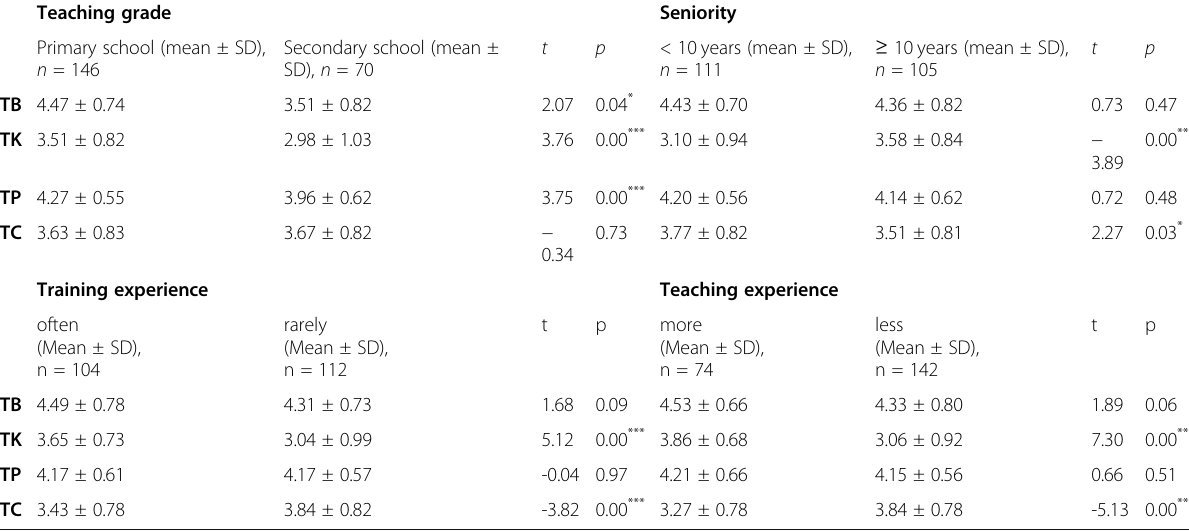
Table 6 Comparison of STB, STK, STP, and STC based on teachers ’ teaching grade, seniority, and the experience STEM training and teaching ( n = 216) Teaching grade